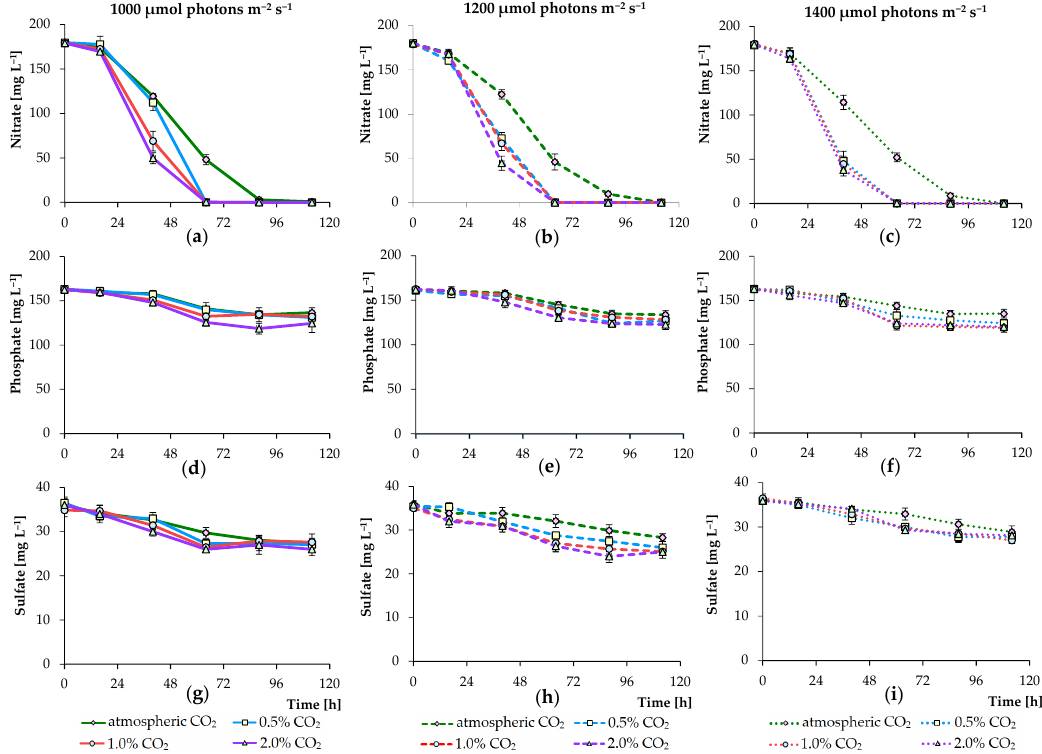
Figure 4. Changes in nitrate ( a – c ), phosphate ( d – f ), and sulfate ( g – i ) concentrations in culture medium during the growth of C. sorokiniana AM-02 cultured under various light and CO 2 regimens (1000, 1200, and 1400 µ mol photons m − 2 s − 1 and atmospheric CO 2 , 0.5, 1.0, and 2.0% CO 2 ) in standard